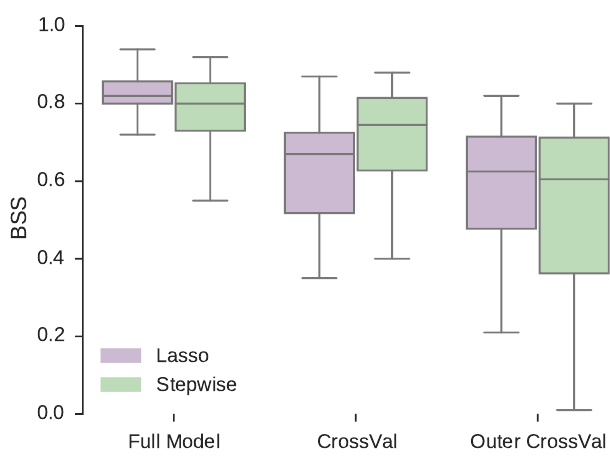
Figure A2. Box plots of the Brier skill score (BSS) of each vali- dation step for the Lasso and the stepwise downscaling algorithms. Each box represents a population of 14 scores (one for each down- scaled variable listed in Table